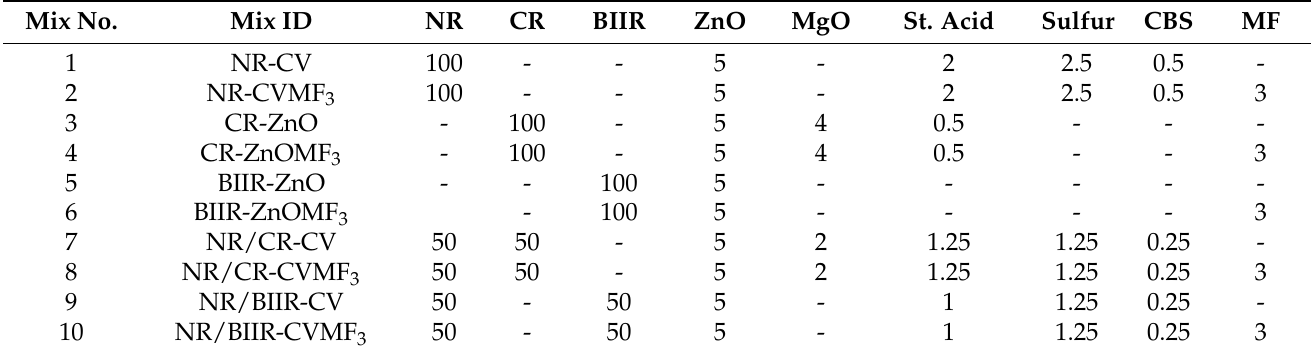
Table 1. Formulation of the